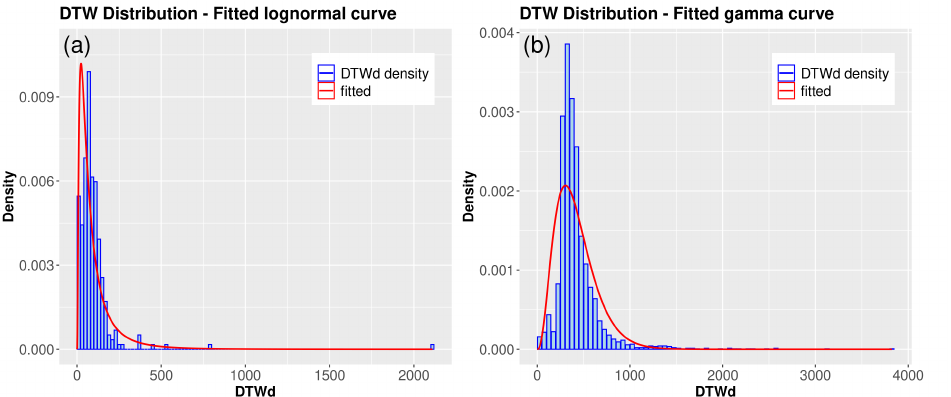
Figure 5. Probability density functions of DTWd values. The red lines are fitted distributions: ( a ) the DTW distance distribution for the CML network in Israel shows a good match to a lognormal distribution. In ( b ), the distribution of DTW distance values in Netherlands is shown, with a fair match to a gamma distribution. In both case studies, the best fitted distributions are exponential in nature, not Gaussian, thus justifying the choice of the IQR outlier filtering